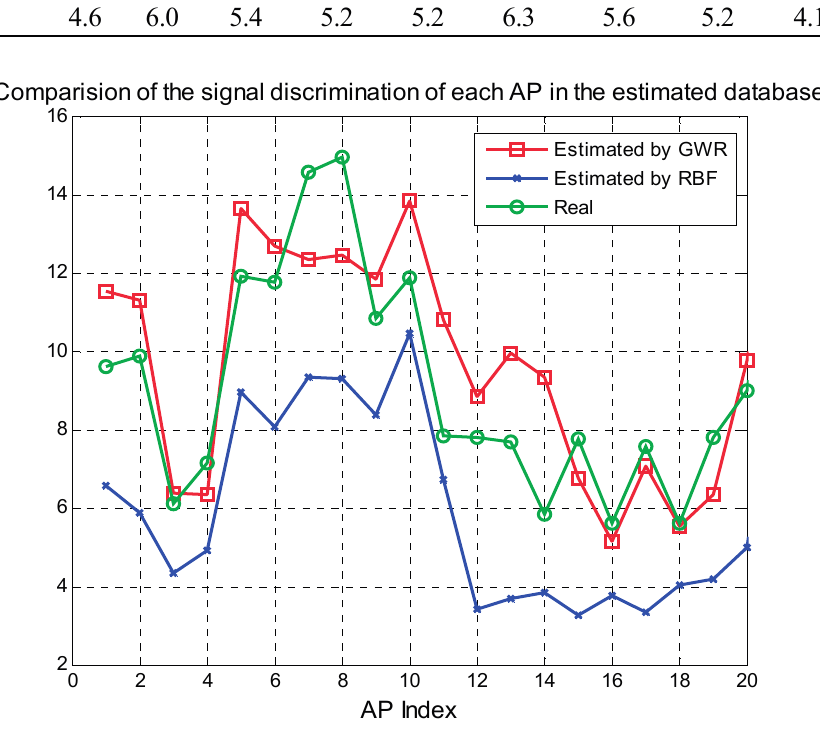
Figure 12. Signal discrimination for RPs in scenario two.